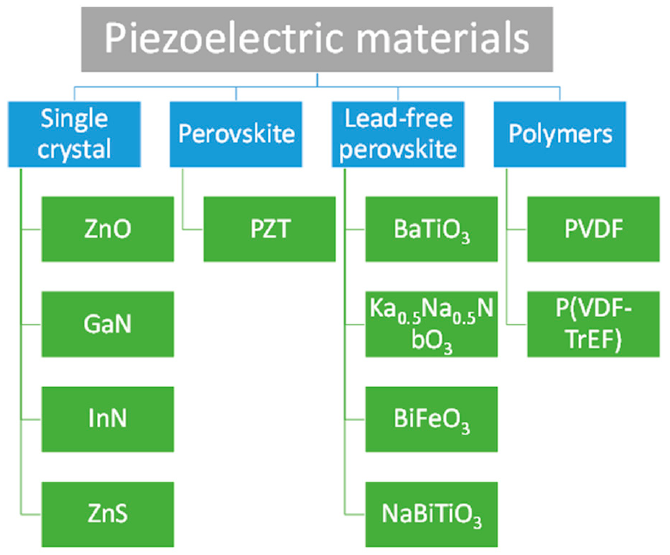
Figure 1. Different classes of piezoelectric materials and examples.